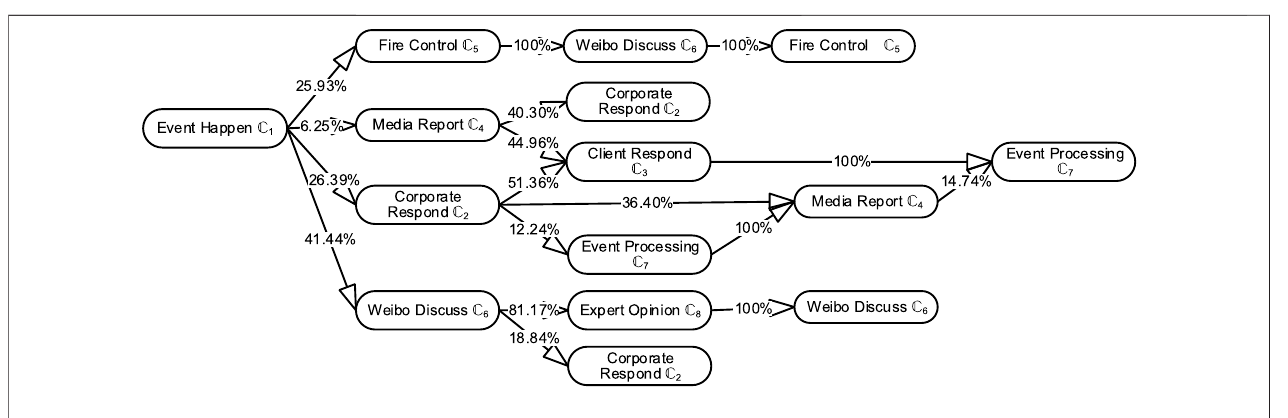
FIGURE 3 | Correlation of sub-events as a topic